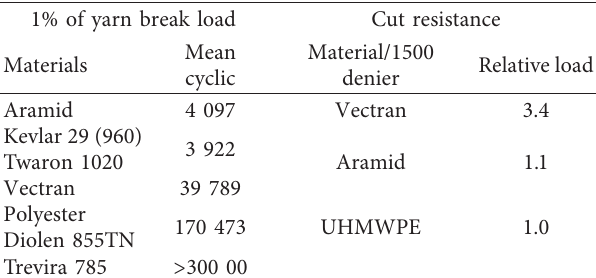
Figure 4: Creep experiment was done for Vectran fiber ropes Table 4: Cyclic failure during wet yarn to yarn abrasion test and cut resistance of different fiber [12].